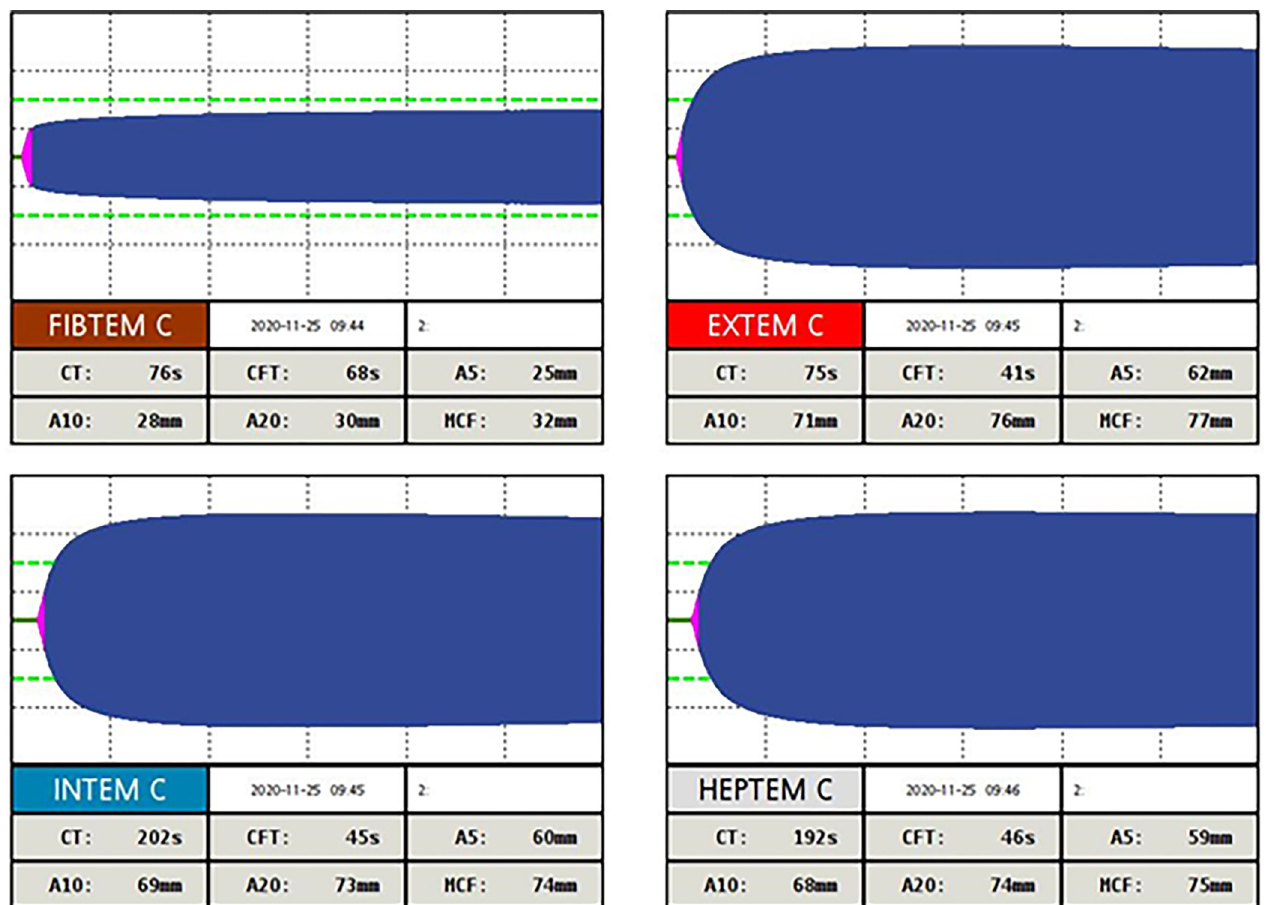
Fig 2. Results of ROTEM tests with the graphical shape performed on admission showing both hypercoagulability and hypofibrinolysis. In this patient, hypercoagulability was characterized by an EXTEM CFT result below normal range values ( < 46 s), and EXTEM A5 and EXTEM MCF results above normal range values ( > 52 mm and > 72 mm, respectively); hypofibrinolysis was characterized by EXTEM Li 60 > 96.5%. CT: Clotting time; CFT: Clot formation time; A5 –A10 –A20: Clot amplitude 5–10–20 minutes after CT; MCF: Maximum clot firmness.